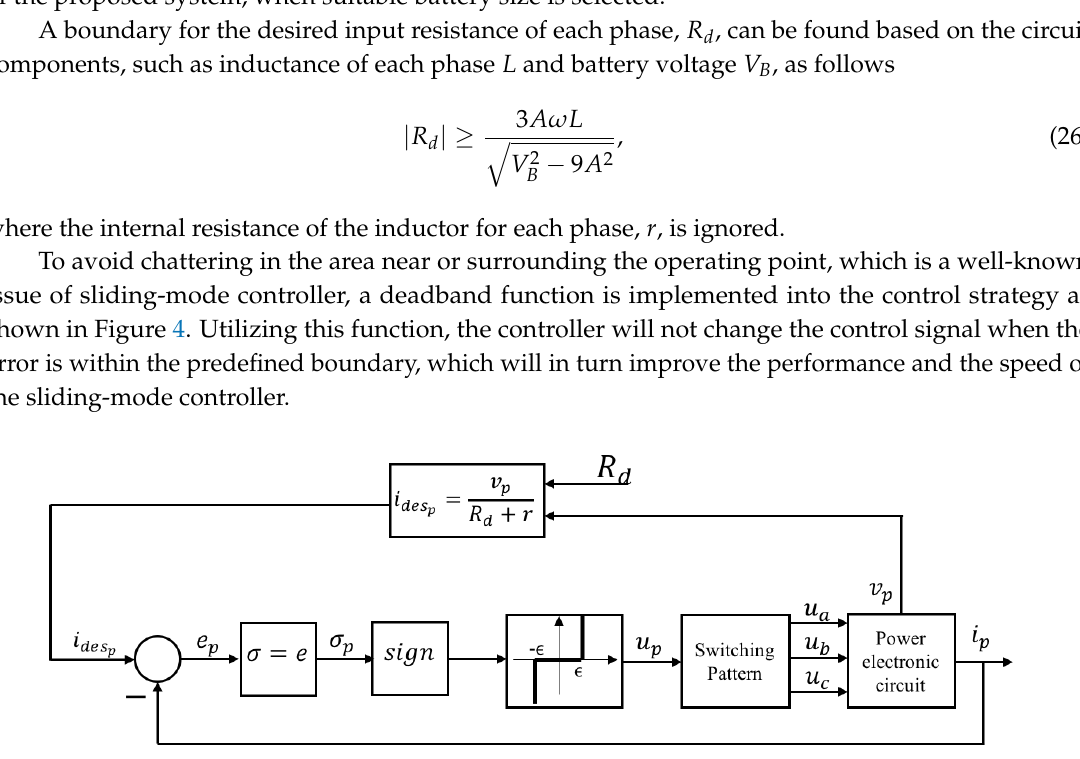
Figure 4. The block diagram of the proposed